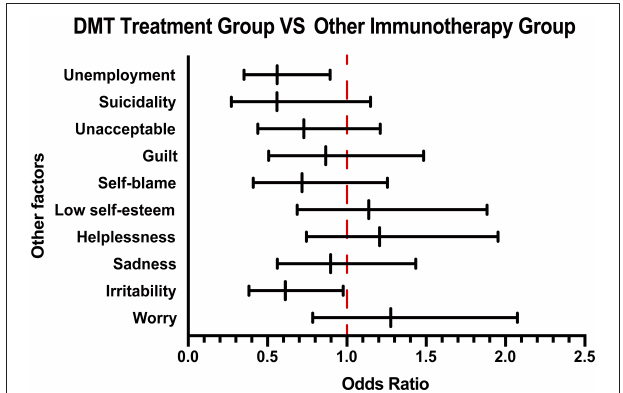
FIGURE 3 | Other emotional and employment factors differing between the DMT-treated group and other immunotherapy group. The forest plot shows odds ratio differences in other factors between the DMT treatment group and other immunotherapy groups. DMT, disease-modifying